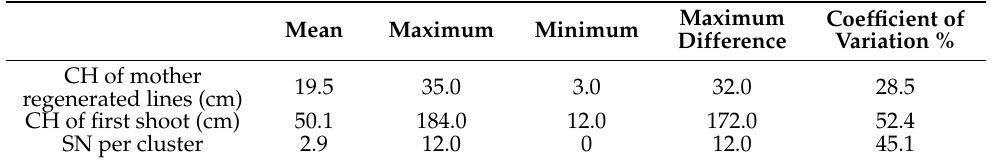
Table 2. Variation of culm heights (CH) and shoot number (SN) in regenerated lines after one year of